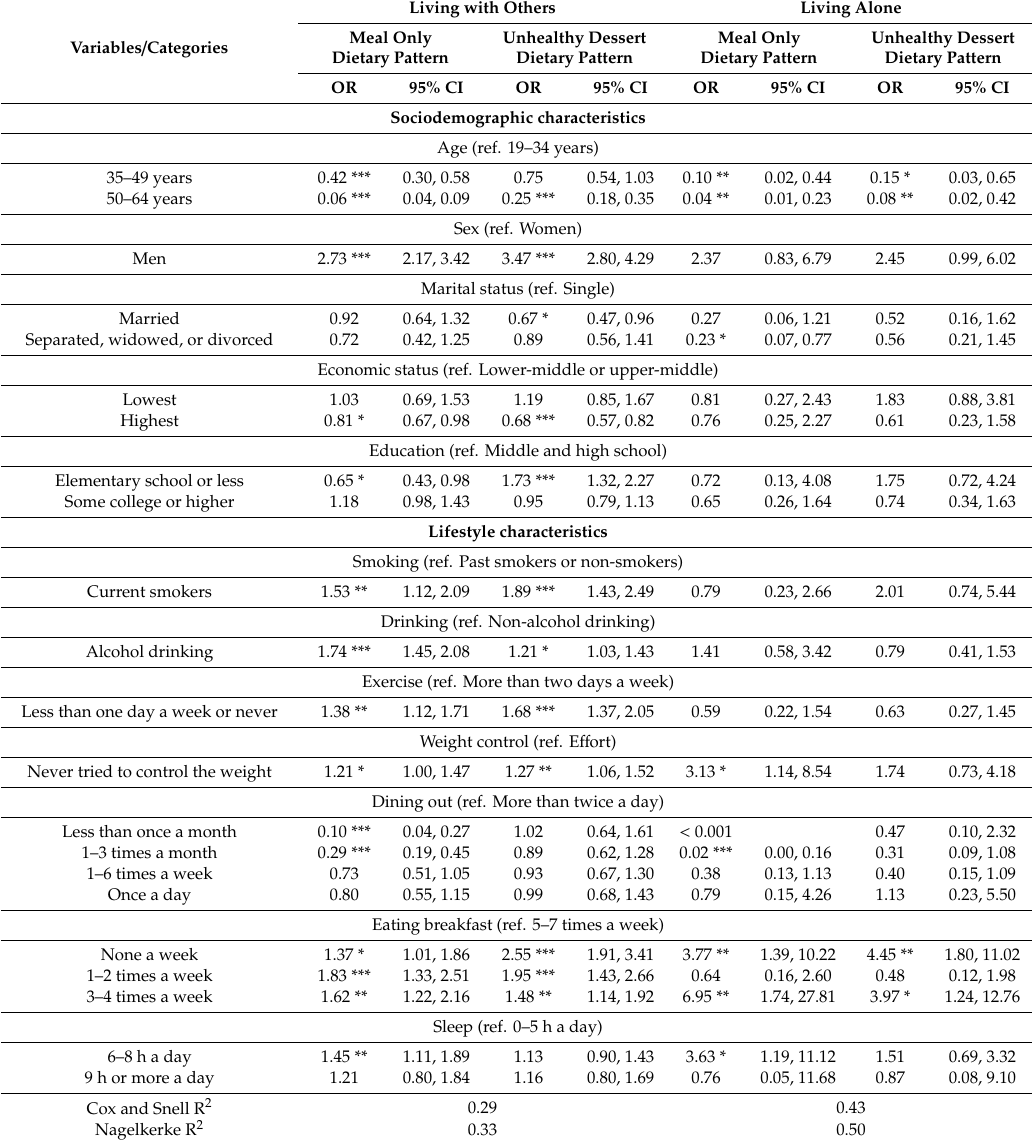
Table 5. Multinominal logistic regression to compare factors associated with dietary patterns depending on living arrangement ( n =